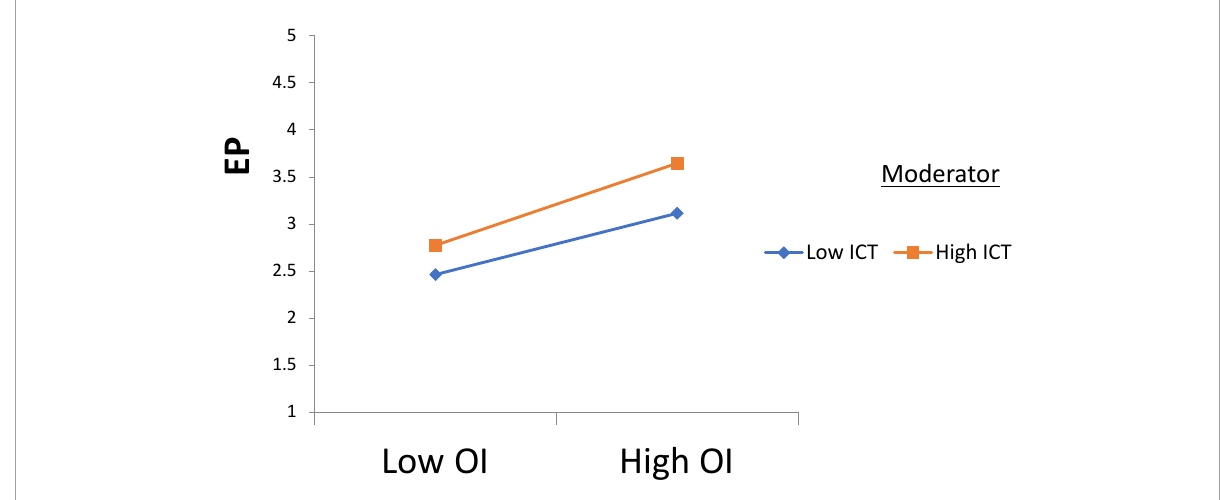
FIGURE5 Moderation effect 3. OI, Open Innovation; ICT, Information Communication Technology; EP, Entrepreneurial Performance.